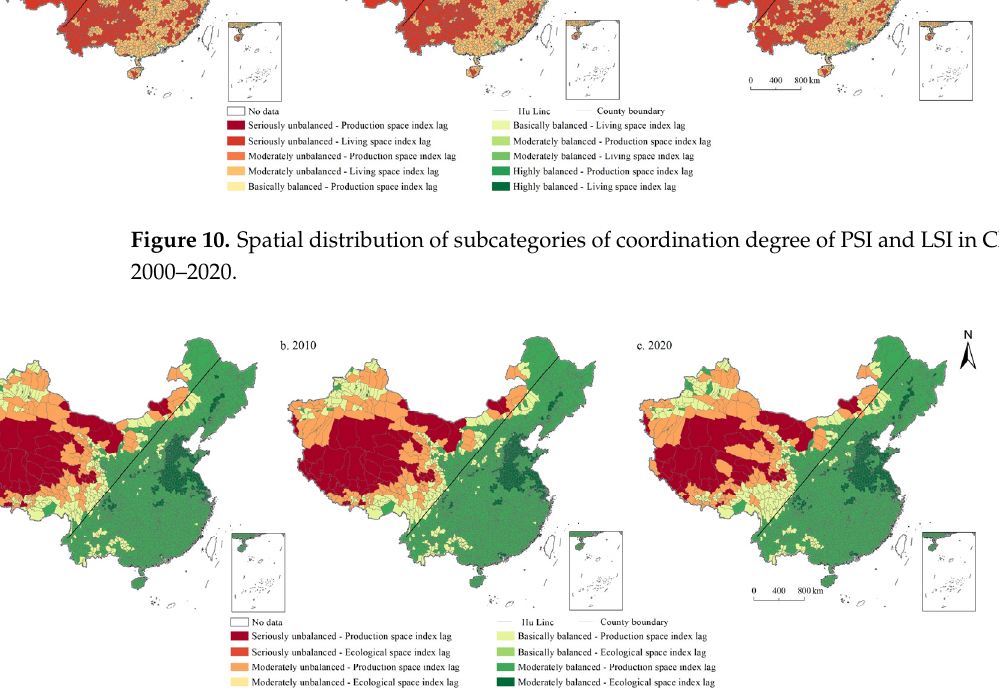
Figure 11. Spatial distribution of subcategories of coordination degree of PSI and ESI in China during